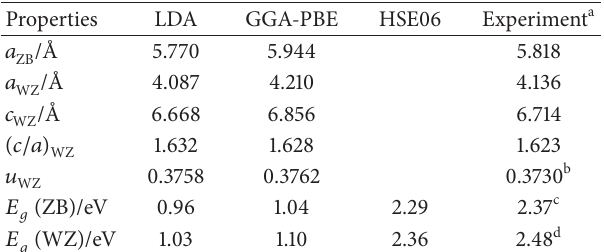
Table 1: Calculated and experimental structural parameters ( a , c , and u ) and band gap ( 𝐸 𝑔 ) of zinc-blende (ZB) and wurtzite (WZ)